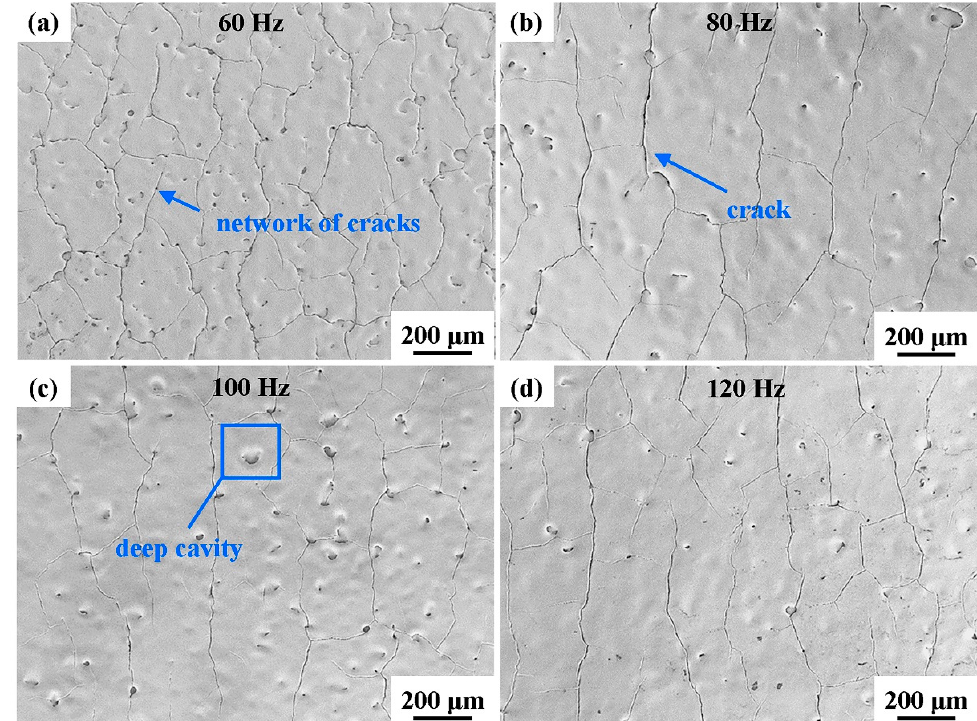
Figure 4. Surface morphologies of the laser-processed coating samples at different scanning frequencies: ( a ) 60 Hz; ( b ) 80 Hz; ( c ) 100 Hz; and ( d ) 120 Hz.